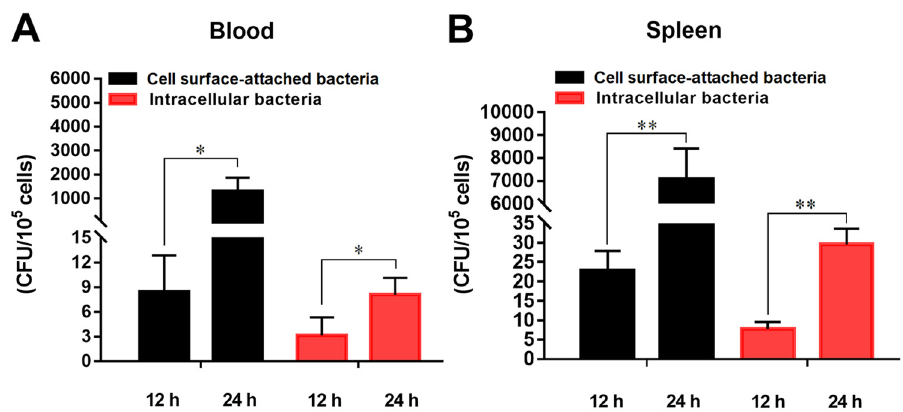
Figure 2. In vivo infection of Edwardsiella tarda in flounder blood and spleen erythrocytes. Flounder were infected with or without (control) E. tarda for 12 h and 24 h, and erythrocytes were collected from blood ( A ) and spleen ( B ). The cell surface-attached and intracellular E. tarda were determined and shown as Colony Forming Unit (CFU). Data are presented as means ± SEM of three independent experiments. *, p < 0.05; **, p < 0.01.